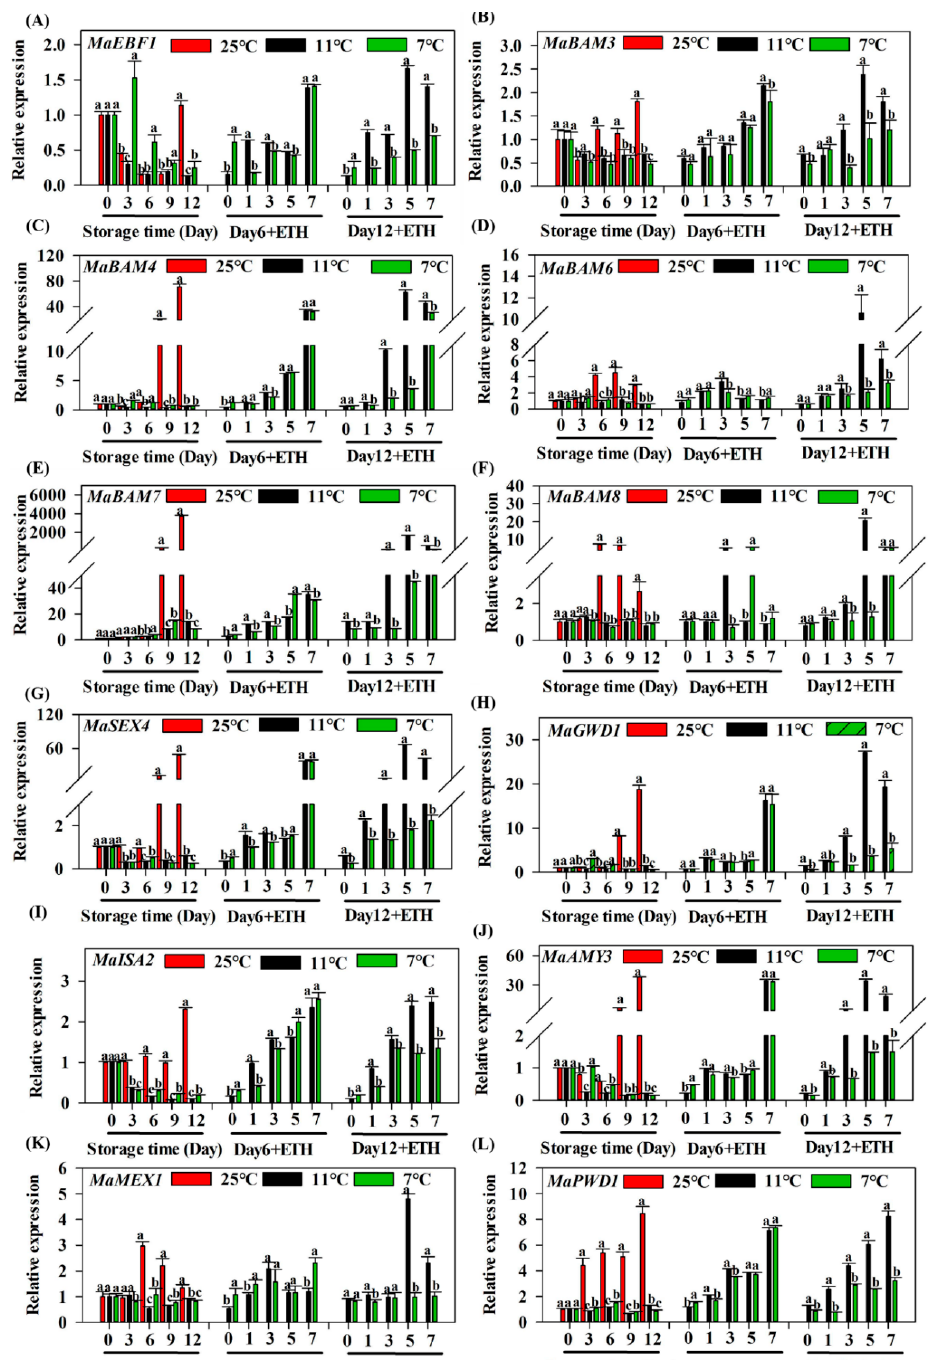
Figure 3. The expression profiles of genes related to starch degradation in Fenjiao fruit pulp under different storage conditions. The expression patterns of MaEBF1 ( A ) and starch degradation genes ( B – L ) after different storage conditions and ripening process. The expression levels of each gene at different days are relative to that of 0 d (freshly harvested fruit), which was set as 1. Each value represents the means of biological triplicates (mean ± SD). Different letters above the bars indicate significant differences at the 5% level. Fruit were stored at 25 °C, 11 °C, and 7 °C for 6 or 12 days, removed to 25 °C, and treated with ethephon.